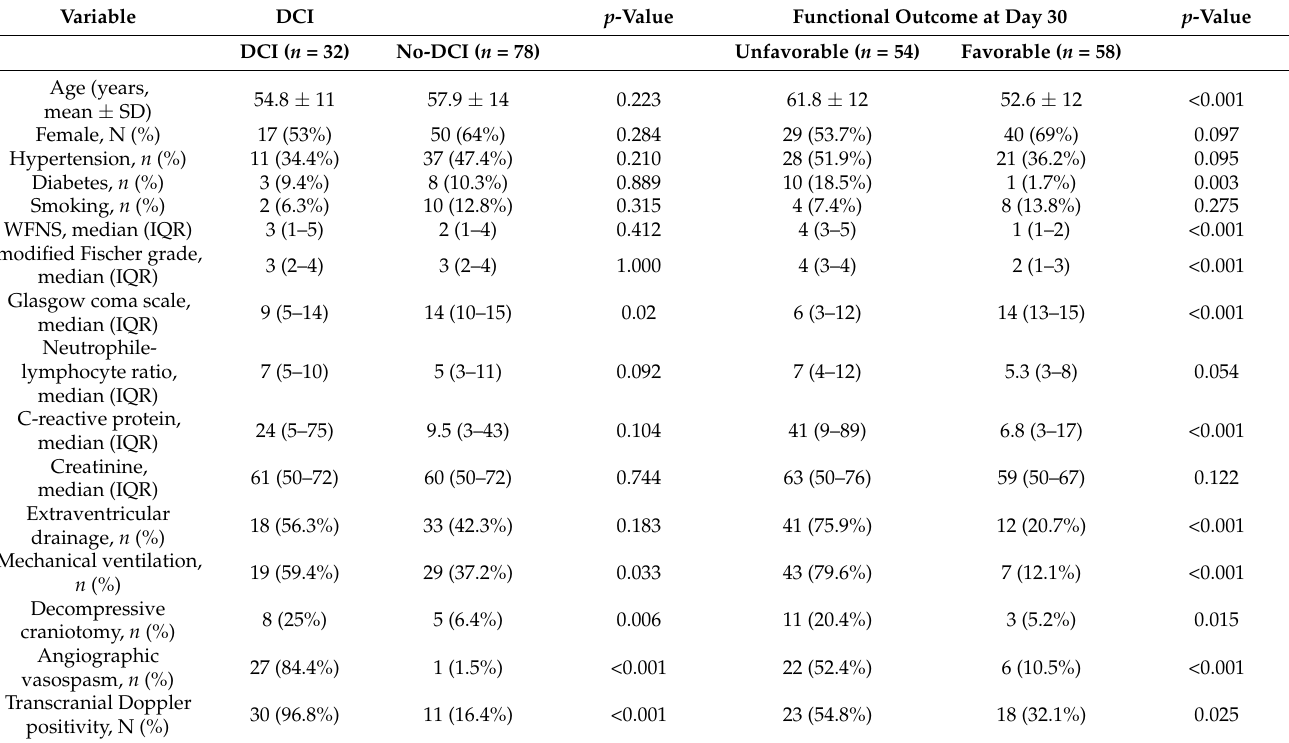
Table 4. Comparison of clinical and biochemical characteristics between patients with and with- out DCI and between patients with unfavorable vs. favorable outcome (Day 30) in patients with aneurysmal subarachnoid